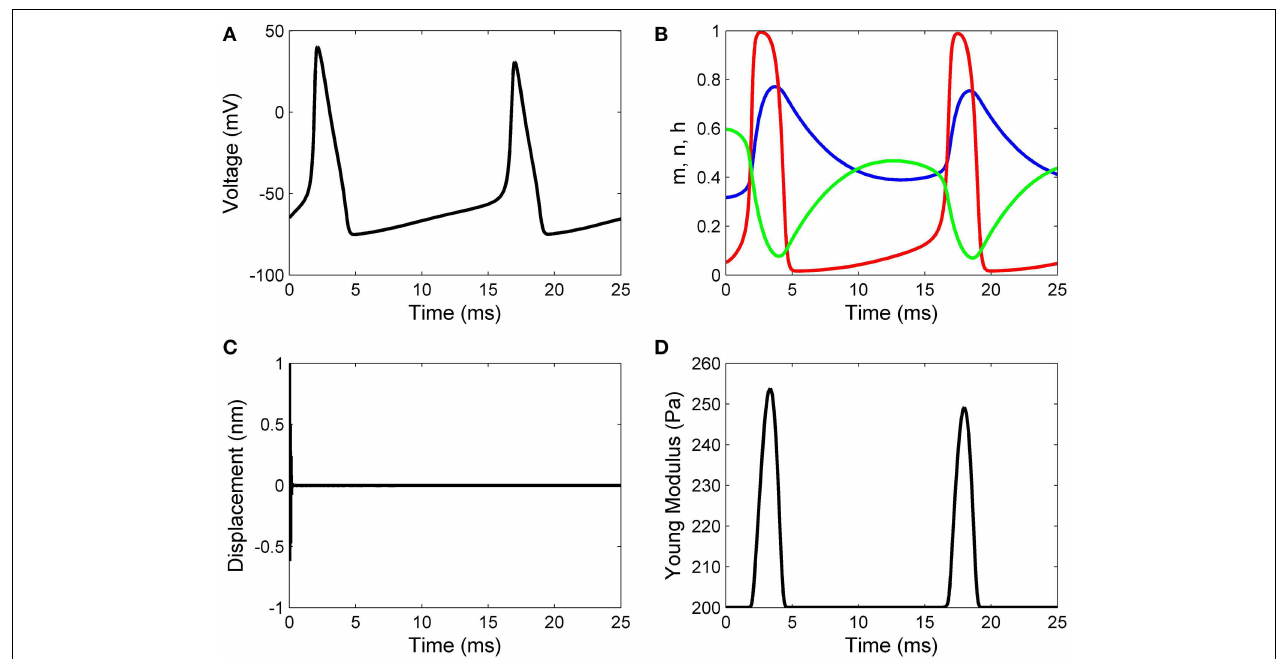
FIGURE 2 | Results for initial displacement of 1nm and initial speed of 10nm/ms: (A) voltage, (B) functions n (blue line), m (red line), and h (green line), (C) displacement, and (D) Young’s modulus.